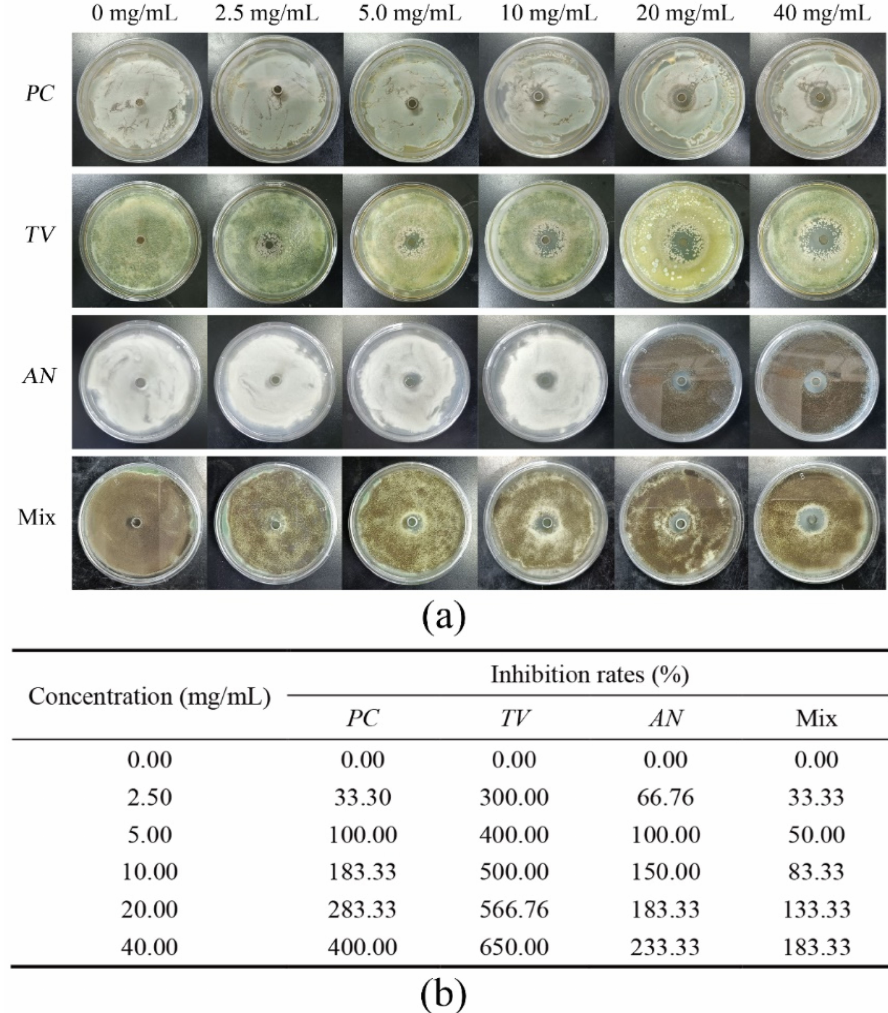
Figure 1. Results of inhibition zone and inhibition rate of different 1-decyl-3-methylimidazole chloride concentrations against bamboo mildew. ( a ) Inhibition zone results; ( b ) inhibition